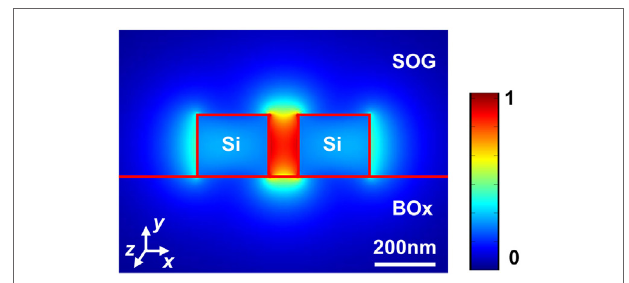
FigUre 1 | Dominant electric field ( │ ex │ ) of the fundamental Te mode guided by the silicon slot waveguide on a buried oxide (BOx) substrate with a spin-on glass (sOg) surrounding medium . The waveguide is 220 nm high, and the slot width is 100 nm with 225 nm wide silicon arms on both